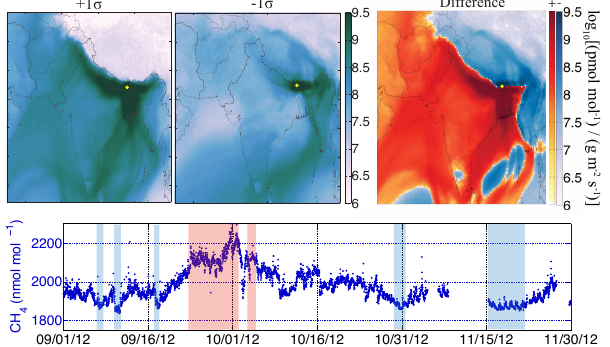
Fig. 9. Median observed CH 4 diurnal cycles (blue circles) and NAME-generated diurnal cycles (black squares) from (a) Decem- ber 2011–February 2012 (winter) and (b) June–August 2012 (sum- mer). Solid blue lines and grey shading indicate the 16th and 84th percentile of the observed and modeled values, respectively, from the